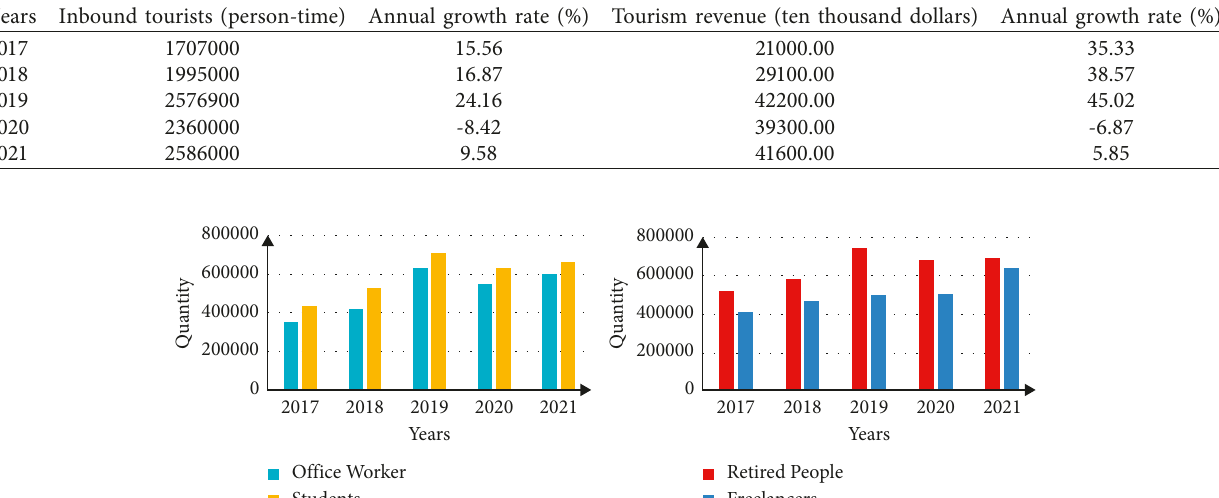
Table 1: Inbound tourism in city A from 2017 to 2021.